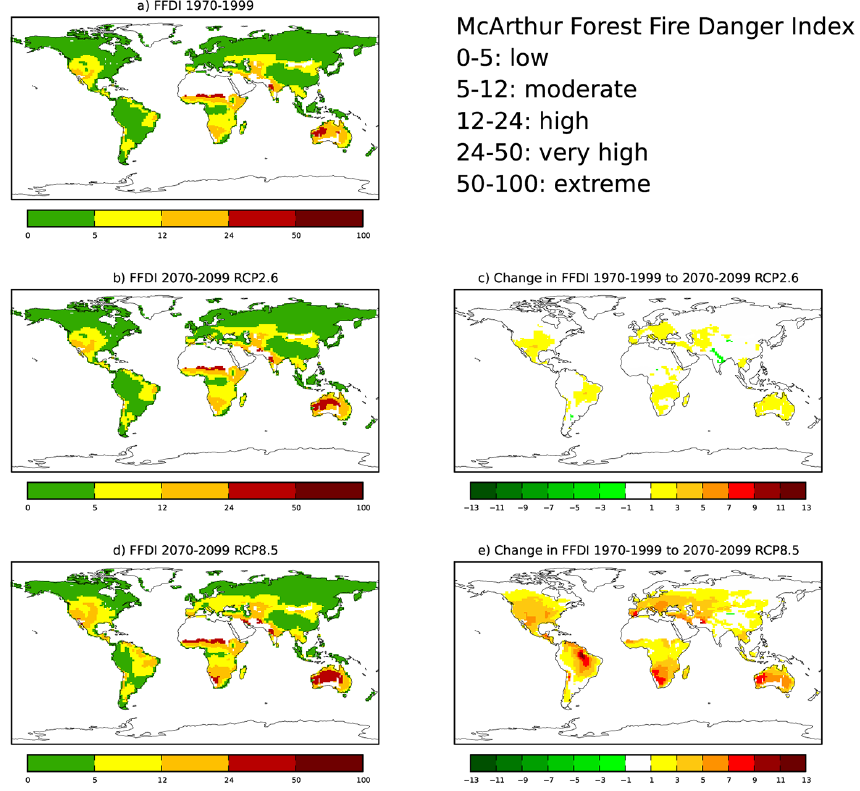
Figure 14. 30-year mean McArthur Forest Fire Danger Index (FFDI) simulated by HadGEM2-ES for (a) 1970–1999 (b) 2070–2099 for RCP2.6 and (c) 2070–2099 for RCP8.5. Changes in FFDI between 1970–1999 and 2070–2099 for (d) RCP2.6 and (e)